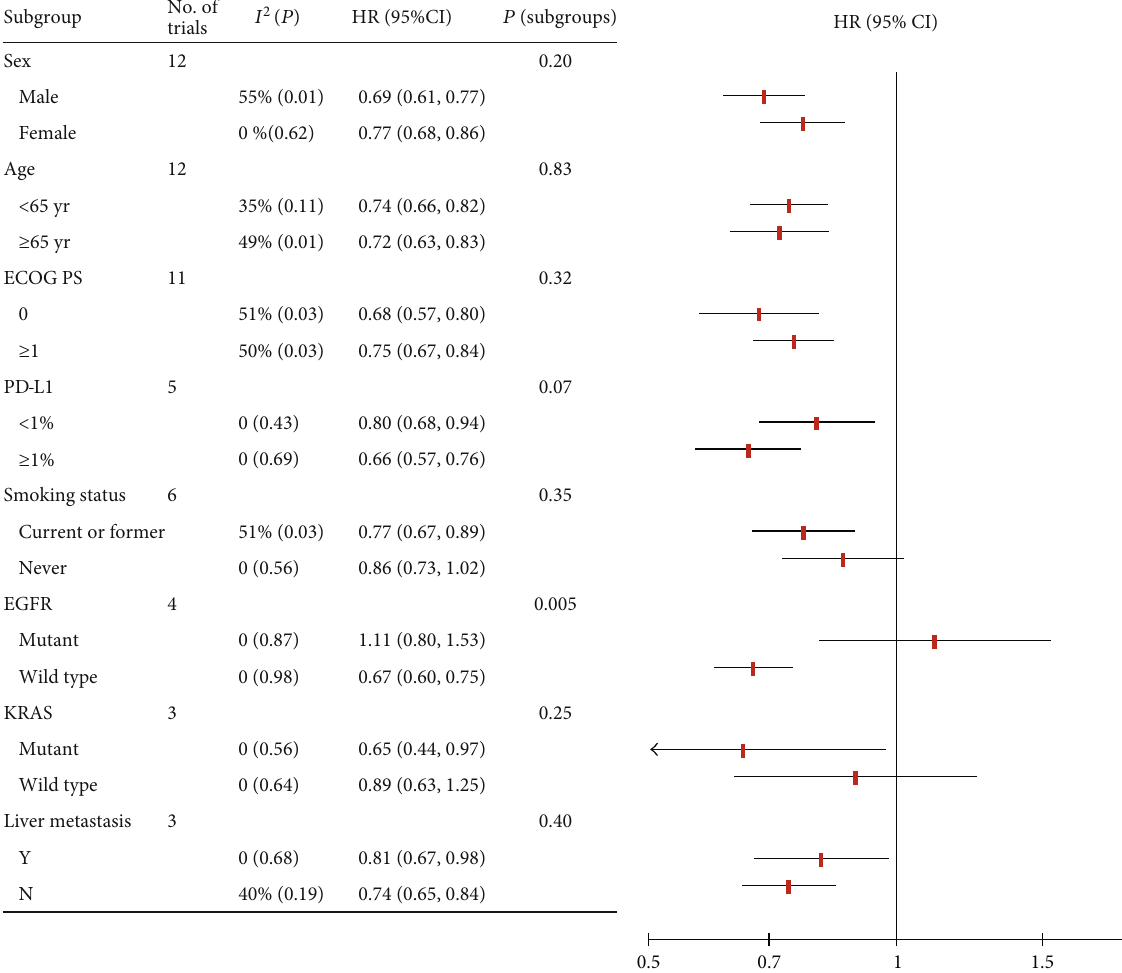
Figure 2: Subgroup analysis for monotherapy. HR: hazard ratio; Y: yes; N: